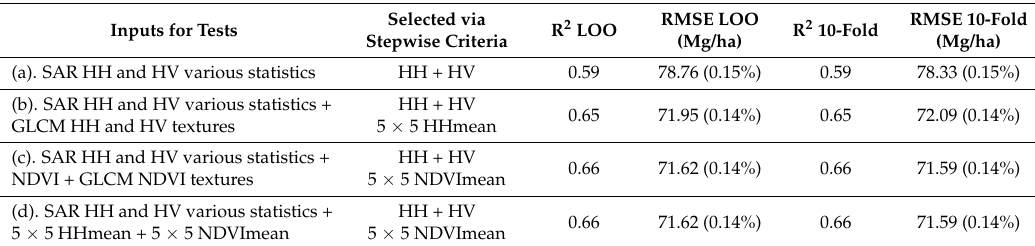
Table 1. Results of the tests conducted with different SAR and optical inputs, using stepwise selection and multiple linear regression, validated with ground truth. RMSE is expressed both in Mg/ha and as percentage.